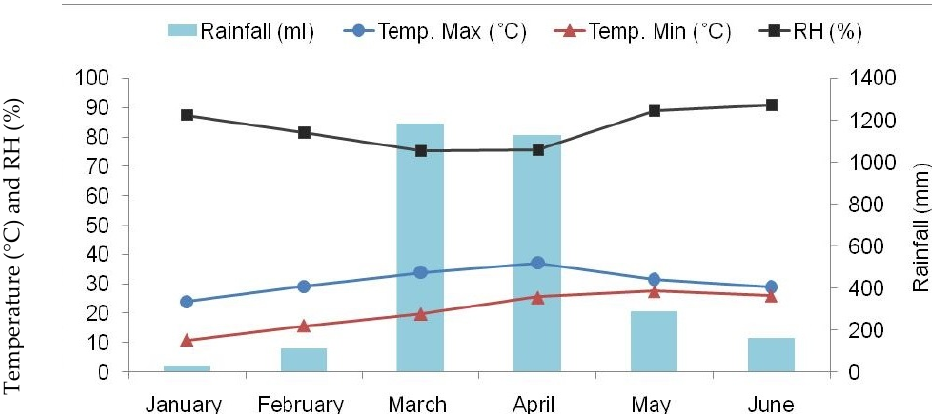
Figure 2. Monthly average maximum and minimum temperature ( ◦ C), relative humidity [RH (%)], and total rainfall prevailed during 2016. Temp.—temperature, Max—maximum, Min—minimum. (Source: Bangladesh Sugar Crop Research Institute).